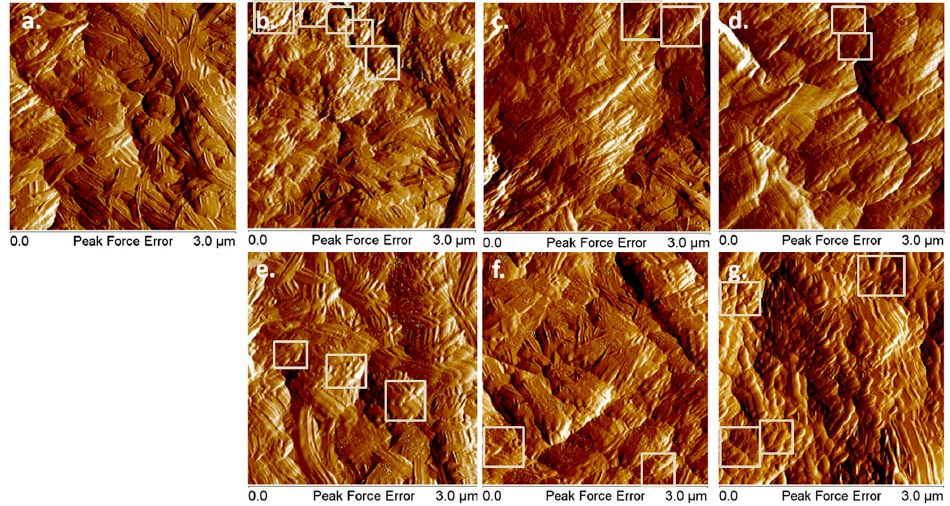
Figure 4. Atomic force microscopy (AFM) images (peakforce error) of untreated ( a ) and plasma treated NC: Ar ( b ); Ar/O 2 ( c ); Ar/N 2 ( d ); Ar/N 2 (E30) ( e ); Ar/NH 3 ( f ); Ar-ACN ( g ); Regions of interest showing small-length nanofibers agglomerations are framed in squares.